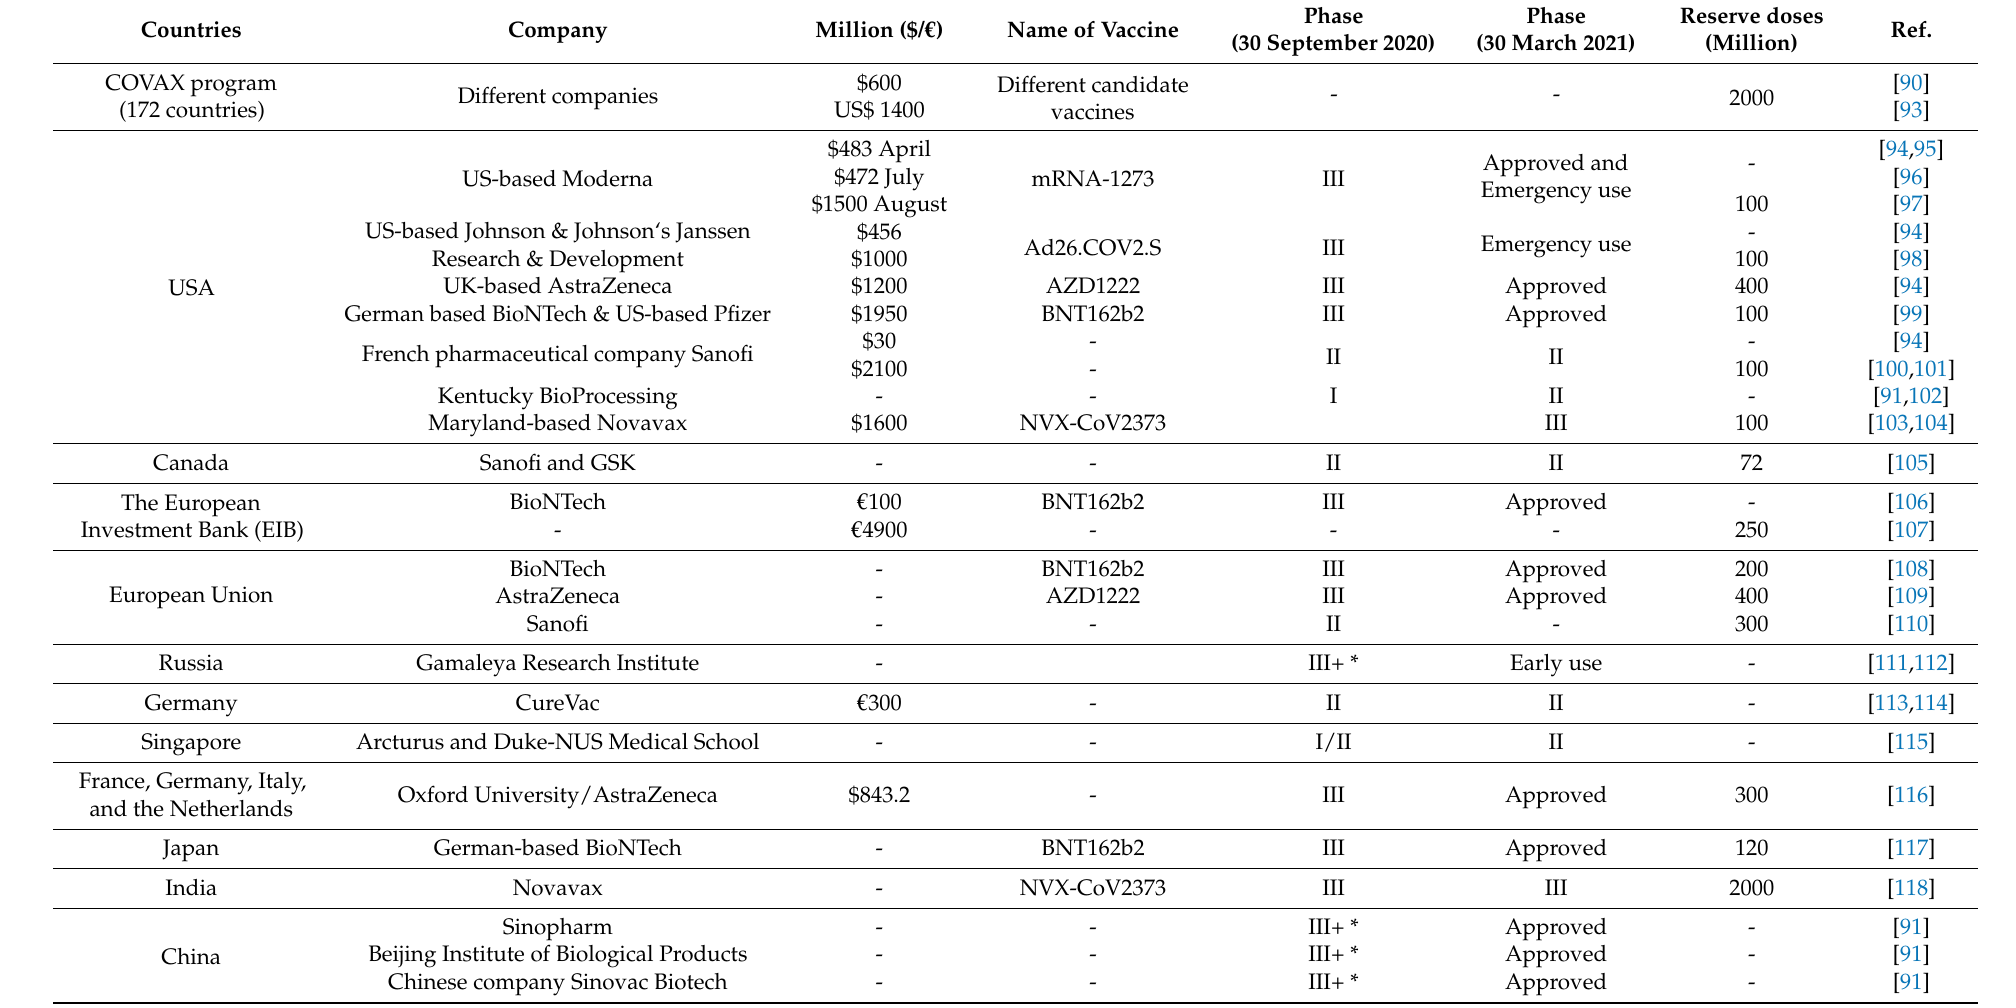
Table 2. Major projects and investments for a COVID-19